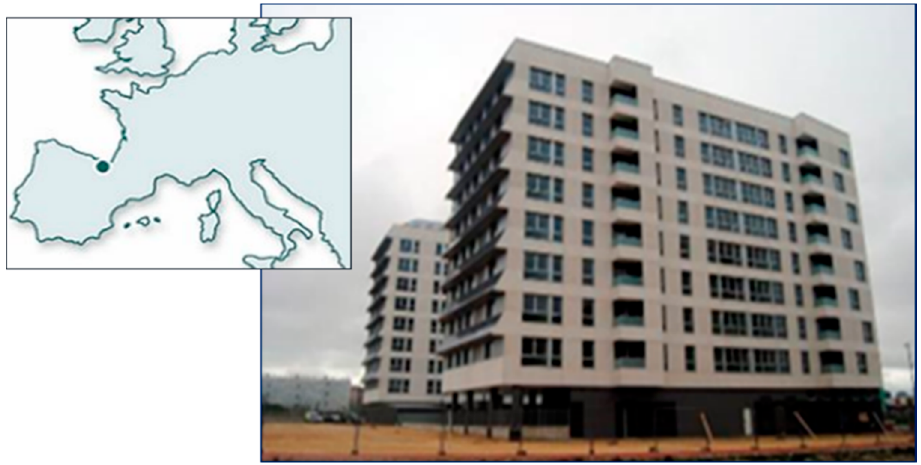
Figure 3. Buildings of the case study in Vitoria-Gasteiz (Basque Country).